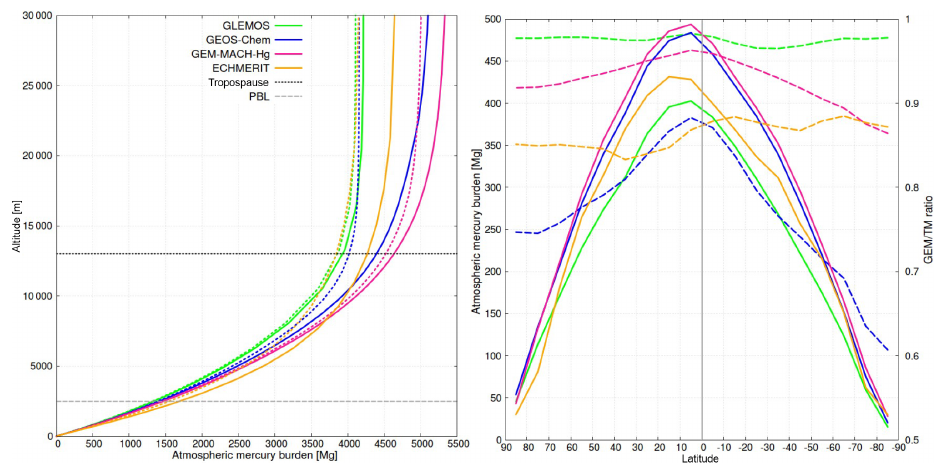
Figure 15. (a) Global cumulative total mercury burden integrated from surface to model level for each of the four global models. Solid lines represent TM and dotted lines GEM. The model ensemble gives a total 4800Mg of mercury in the atmosphere with 1500Mg inside the PBL, 2800Mg in the free troposphere, and 500Mg in the stratosphere. (b) Latitudinal mercury distribution. Solid lines represent total mercury and dashed lines indicate the GEM / TM